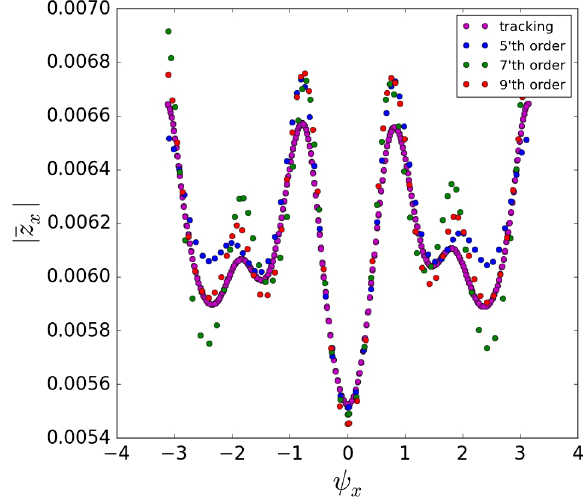
FIG. 5. Detail of curves in Fig. 4 with constant j w seventh, and ninth order (blue, green, red) in ¯ z compared with the result of tracking 512 turns (magenta).